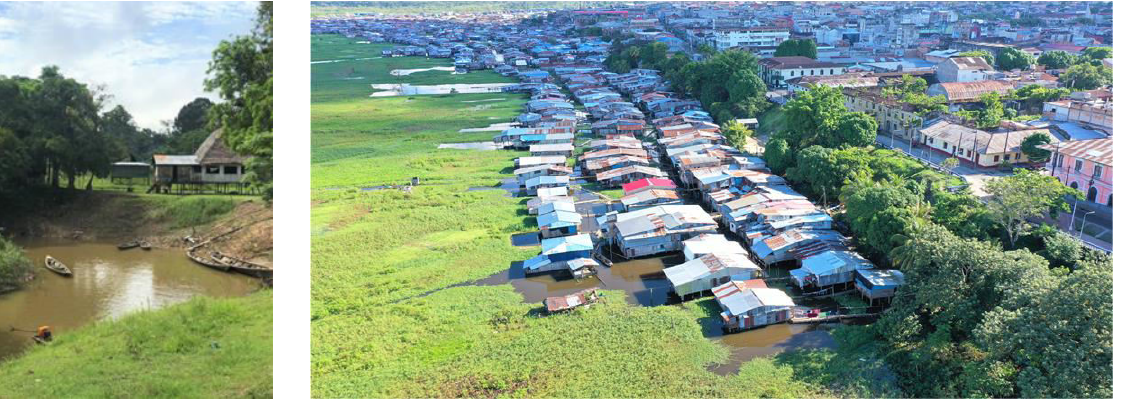
Figure 2 Salaverry urban amphibious slum in Iquitos